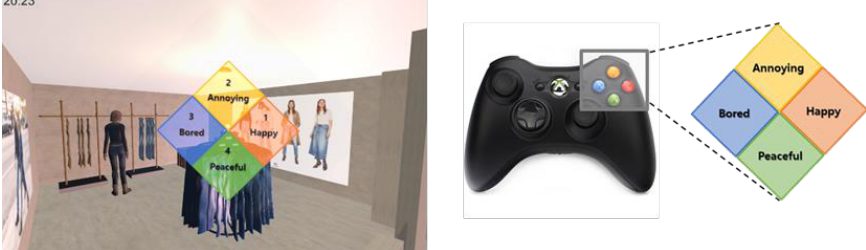
Figure 12. Emotion collection screen ( left ) and emotion input button ( right ).